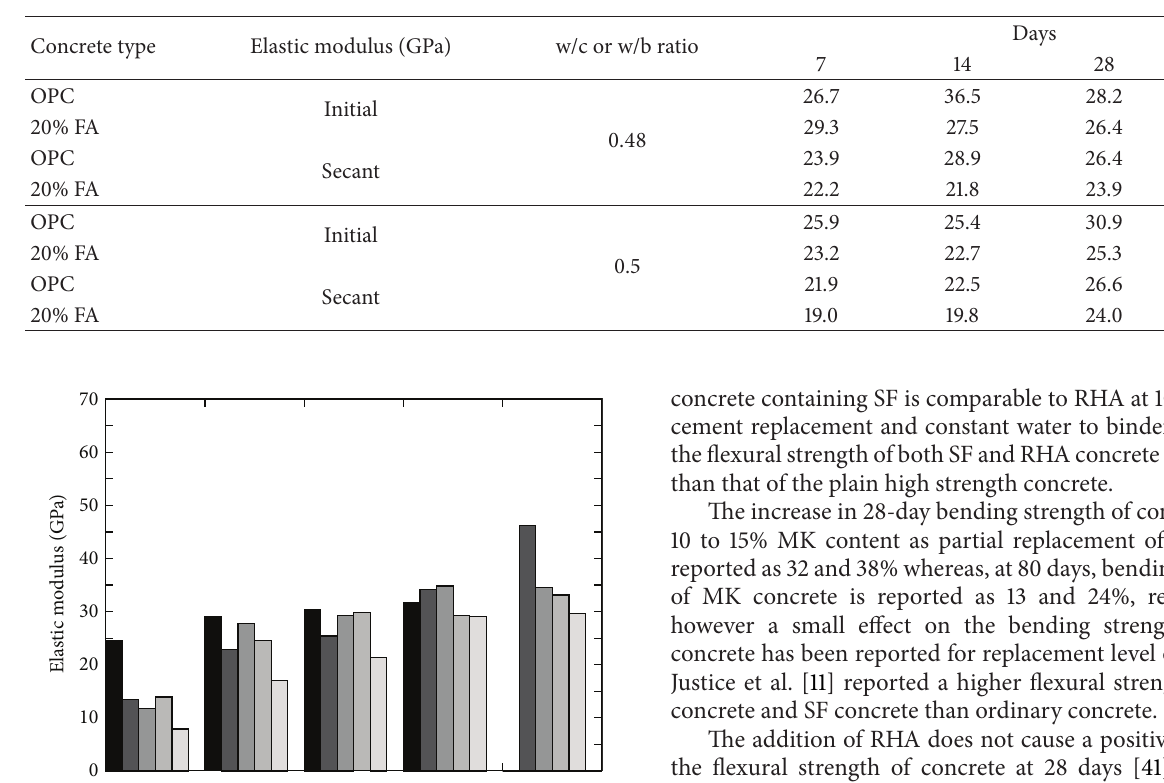
Table 3: Elastic modulus of OPC and FA concrete [25].